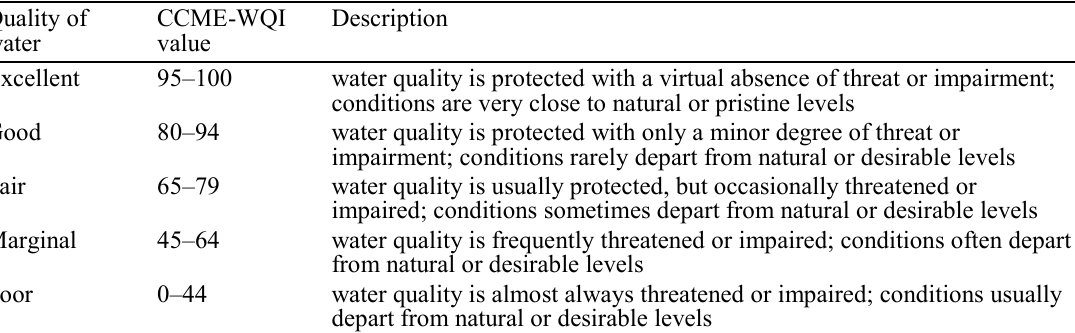
Table 3 CCME Water Quality Index